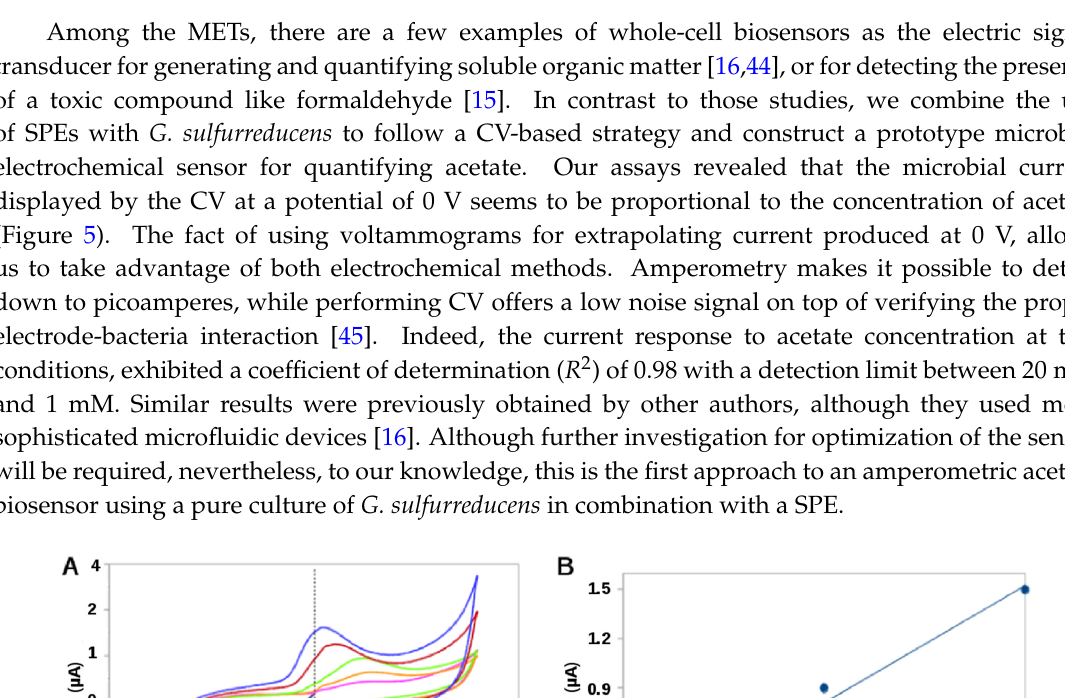
Figure 4. Electricity consumption by a microbial consortium ( red ) and G. sulfurreducens ( blue ) and buffer control ( black ) using nitrate (2 mM) as TEA, polarized at − 0.5 V.